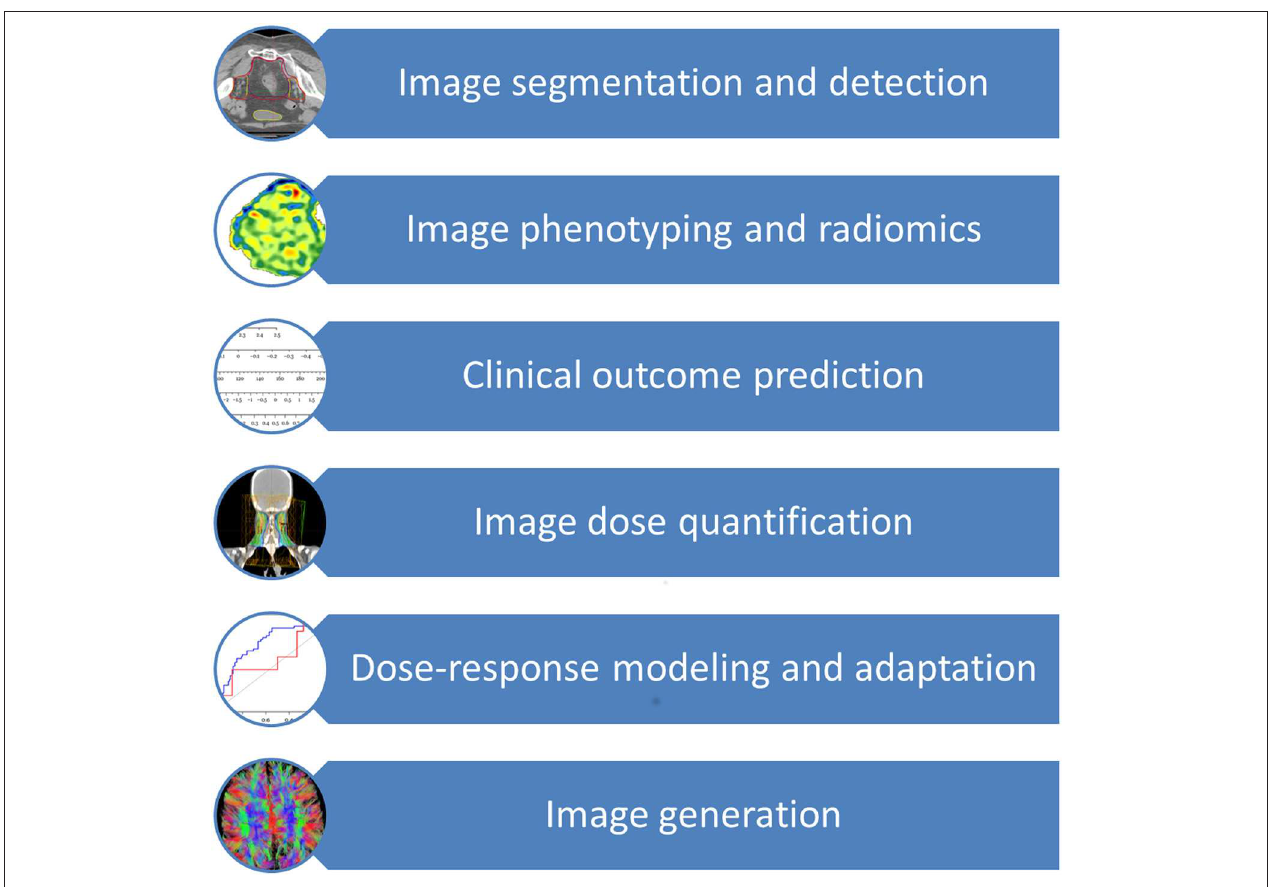
FIGURE 1 | Clinical applications of deep learning in radiation